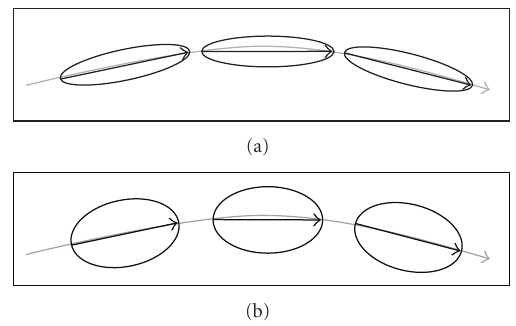
Figure 2: Schematic illustration of deterministic tractography, in a normal subject (a), three adjacent voxels have a clearly directed primary di ff usion direction (longitudinal di ff usion) indicated as ellipsoidal tensor. A deterministic tractography analysis would result in the indicated tract. Another subject, for example, a patient with a neurodegenerative disease (b) might have a reduction of the directivity of di ff usion, evident as less ellipsoidal and more spherical tensors. The direction of the principal direction is however unchanged. This explains why a deterministic tractography analysis may result in the same reconstructed tract (primary direction unchanged) although the di ff usion tensor is less ellipsoidal (reduced FA